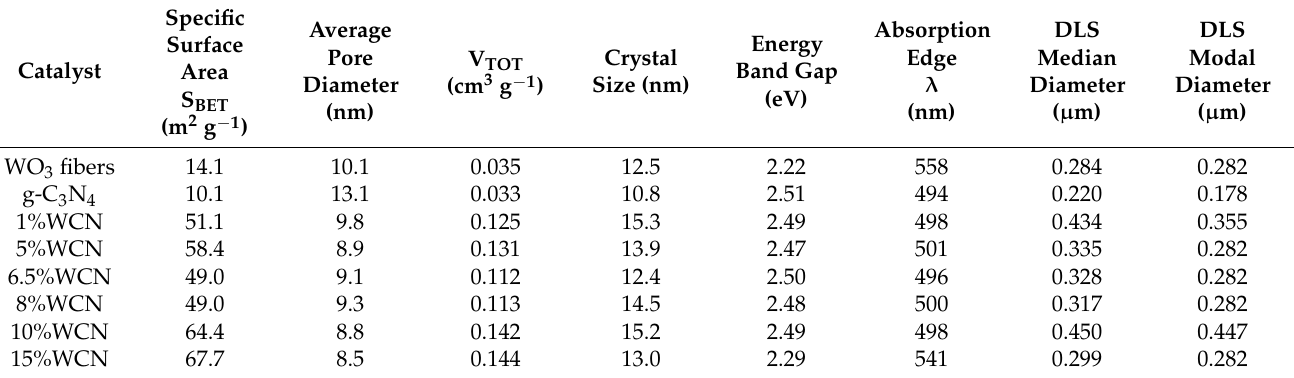
Figure 2. FT-IR spectra of WO 3 fibers, g-C 3 N 4 and composite materials of WO 3 /g-C 3 N 4 .